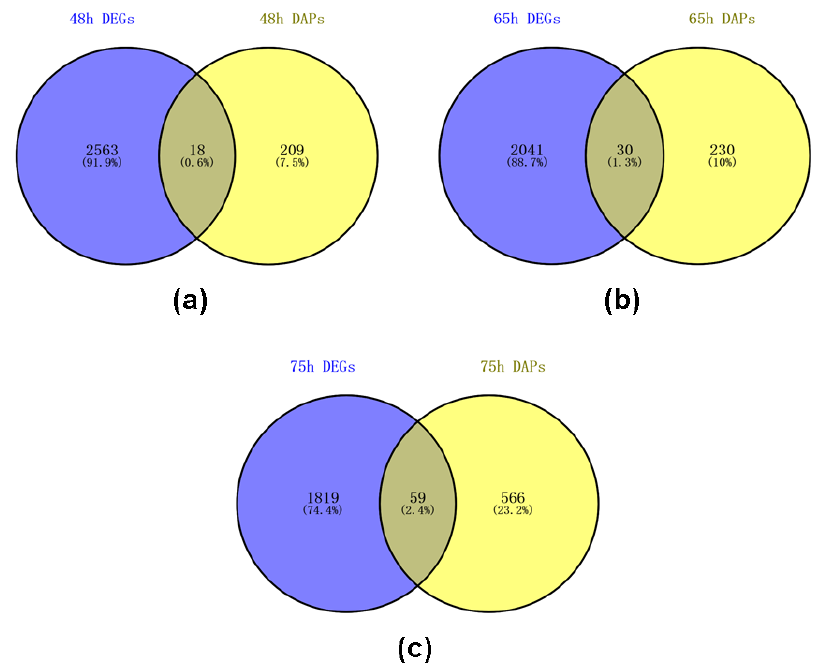
Figure 4. Venn analysis of di ff erentially expressed genes (DEGs) and DAPs of pistils between self- and cross-pollinated in C. oleifera : ( a ) Venn analysis of DEGs and DAPs of pistils at 48 h after self- and cross-pollinated in C. oleifera ; ( b ) Venn analysis of DEGs and DAPs of pistils at 65 h after self- and cross-pollinated in C. oleifera ; ( c ) Venn analysis of DEGs and DAPs of pistils at 75 h after self- and cross-pollinated in C. oleifera